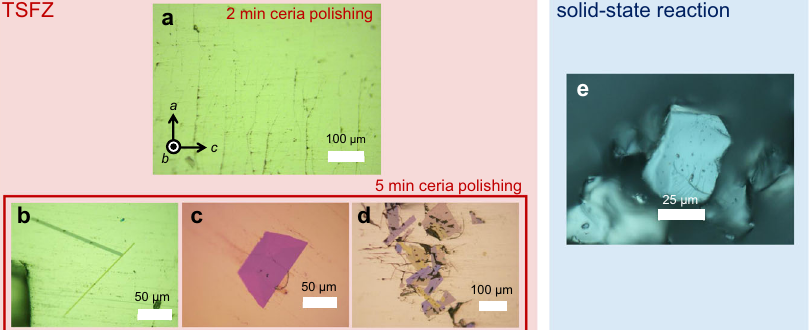
Fig. 7 Polarised optical microscopy. The ca plane of the single crystal synthesised using the TSFZ method subjected to a 2 min and b – d 5 min ceria polishing along the c axis, followed by the rough polishing using sandpapers. b – d Show the uniformly coloured strip-like areas, suggesting that the plates are the single crystal. e An as-prepared crystal grain synthesised by the solid-state reaction method with a higher calcination temperature than that set for the nanosheet